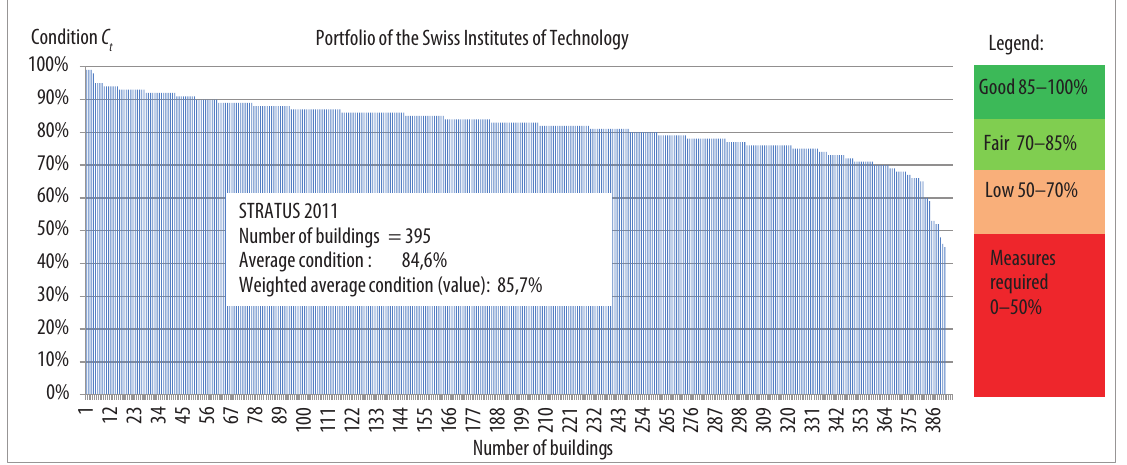
Fig. 3. Typical summation curve of the condition of a portfolio – for those objects below 70% an object strategy is needed (range of descriptions of condition is based on practical